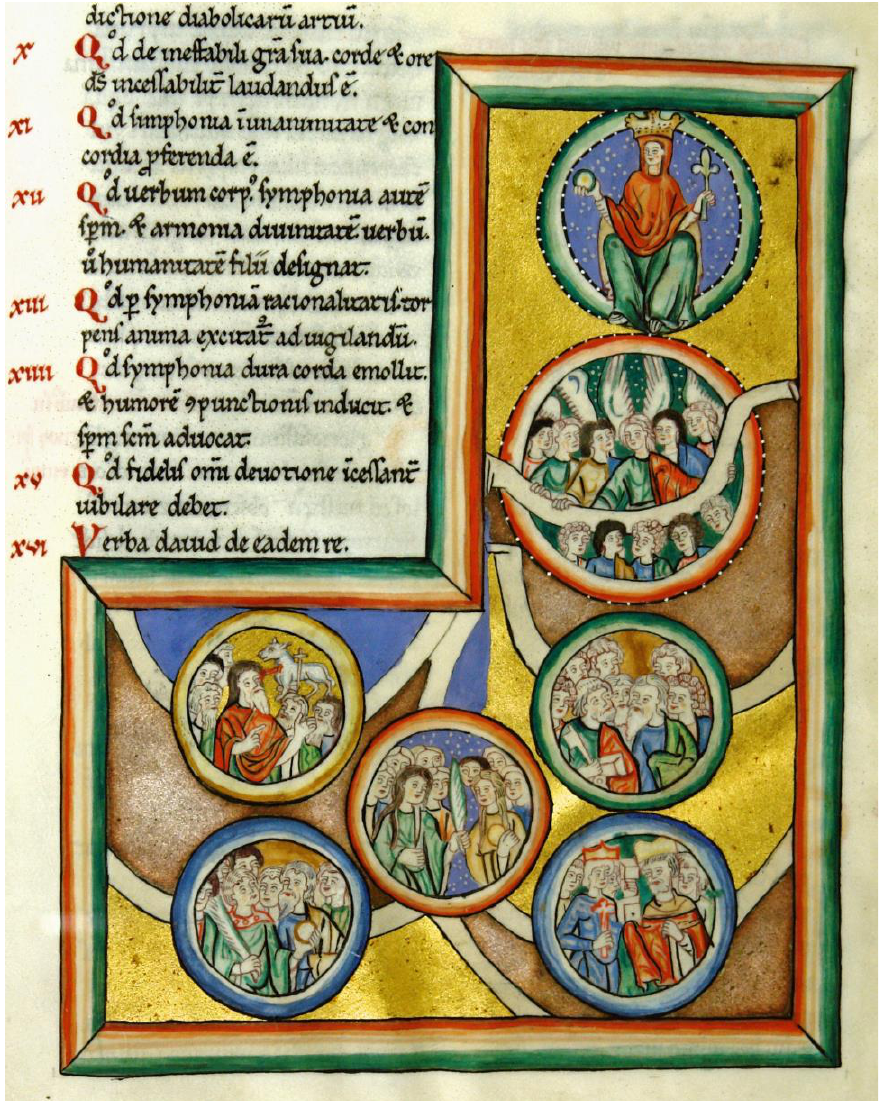
Figure 7. Scivias 3.13: The Symphony of the Blessed. Rüdesheim/Eibingen, Benediktinerinnenabtei St. Hildegard, MS 1, fol. 229r. By permission of the nuns of the Benediktinerinnenabtei St. Hildegard.